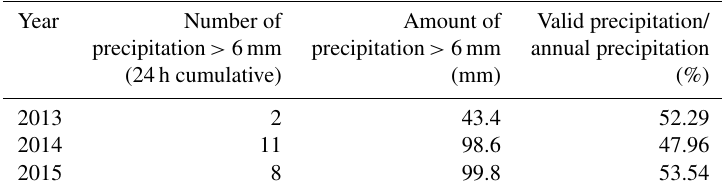
Table 2. Percentage of valid precipitation in total precipitation amount.